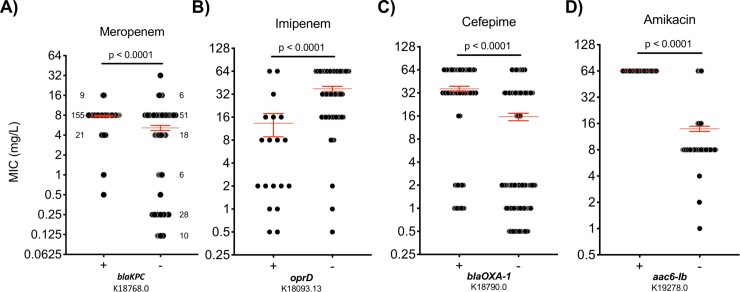
Examples of variant-phenotype relationships determined by the association models.(A) K18768.0 indicates blaKPC, the K. pneumoniae carbapenemase. The presence of blaKPC is associated with resistance to ceftazidime in K. pneumoniae as shown. The numbers in the plots represent the frequency of certain MIC (minimal inhibitory concentration) values. Numbers in the plot represent total number of isolates with the given MIC value. (B) K18093.13 is oprD, an imipenem/basic amino acid-specific outer membrane pore; absence of oprD is associated with resistance to imipenem in P. aeruginosa. (C) K18790.0 represents blaOXA-1, the beta-lactamase class D OXA-1. Its presence is associated with resistance to cefepime in E. coli. (D) K19278.0 is aac6-lb gene. The presence of this variant is associated with amikacin resistance in A. baumannii. The “+” and “-”sign in the X-axis represent whether the wild-type gene exists or not. The red horizontal lines mark the mean and standard error of the groupwise MIC measurements. Each gray dot represents an MIC value. P-values are calculated based on Fisher’s exact test. MIC: minimal inhibitory concentration.